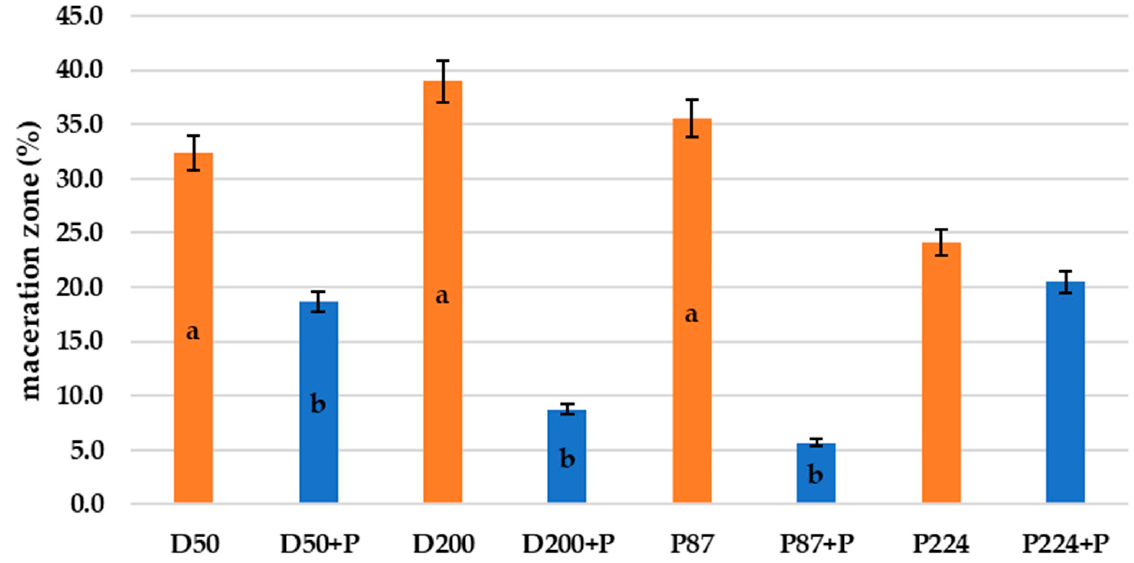
Figure 6. Effect of phage treatment on potato bacterial rots in whole potato tubers after 7 days of storage at 25 °C; ( A ) D50; ( B ) D200; ( C ) P87; ( D ) P224.